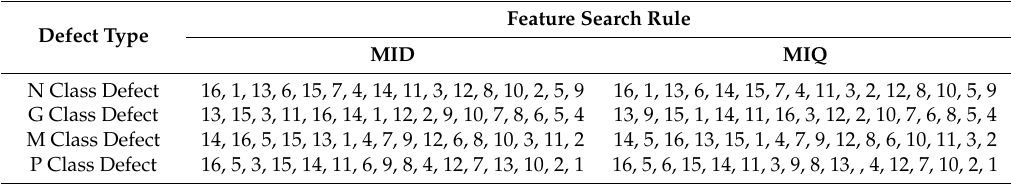
Table 7. Assessment feature subsets in descending order under M, P, and G class